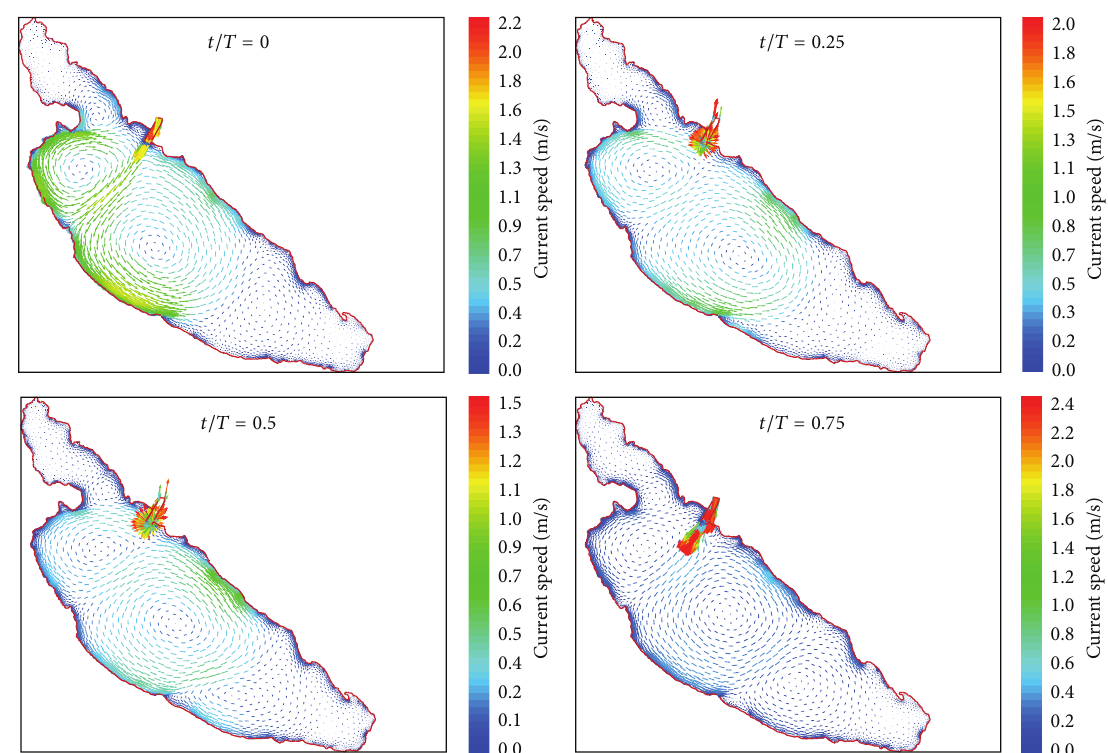
Figure 5: Velocity fields and magnitudes corresponding to those in Figure